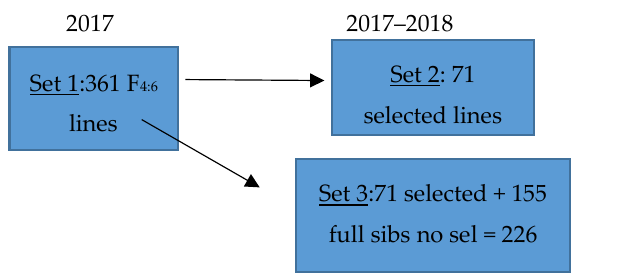
Figure 1. Diagram of the six sets used in the study and relationships among them.